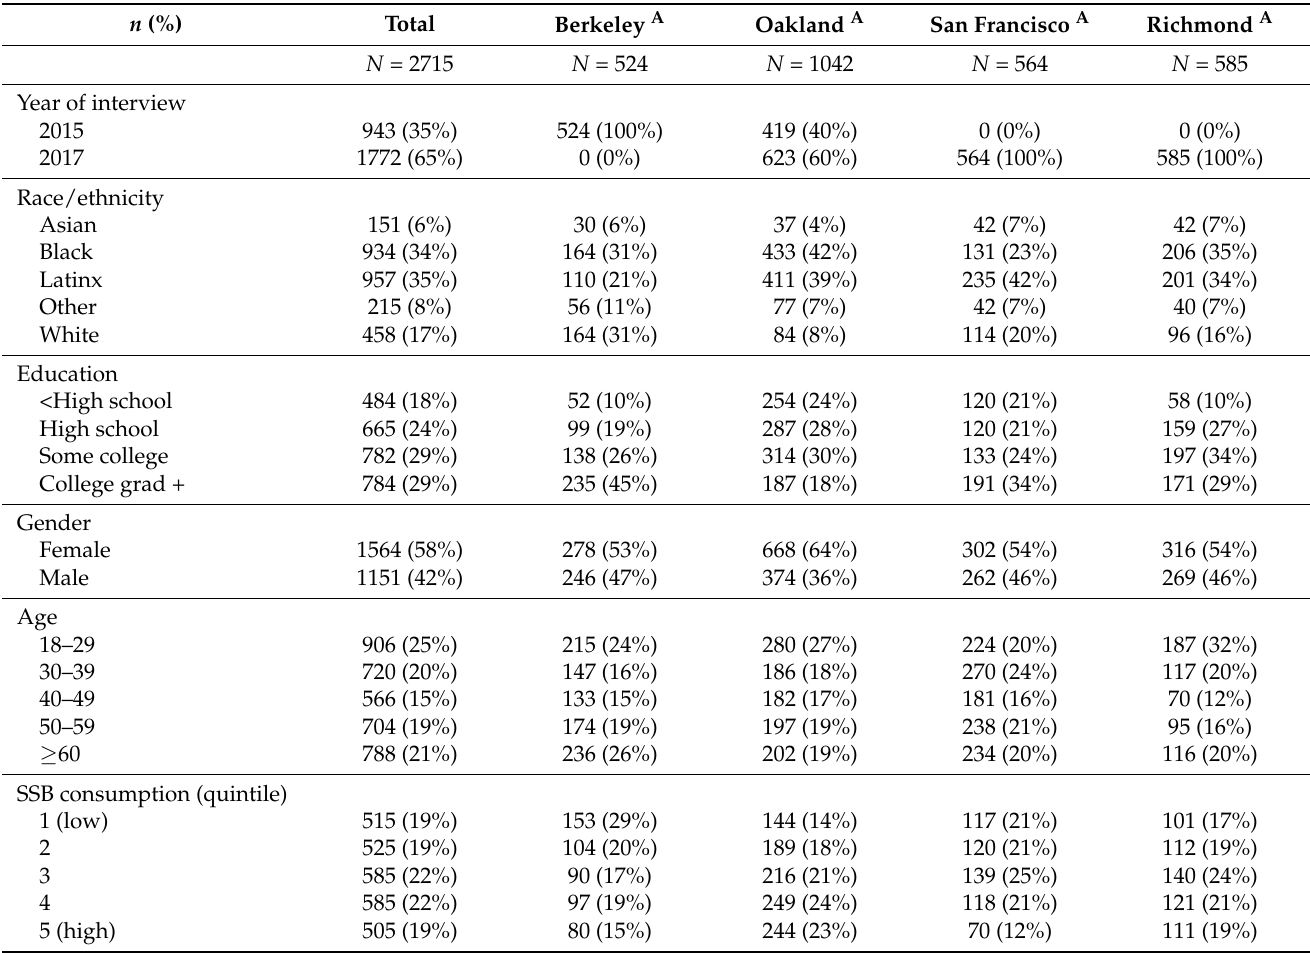
Table 1. Respondent characteristics by city, 2015 and